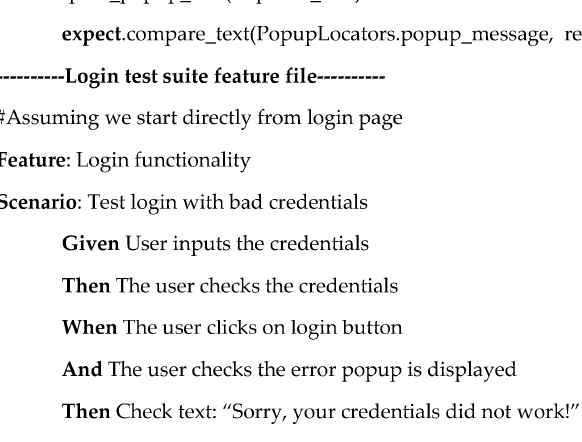
Figure 13. Login test example using Gherkin [16].